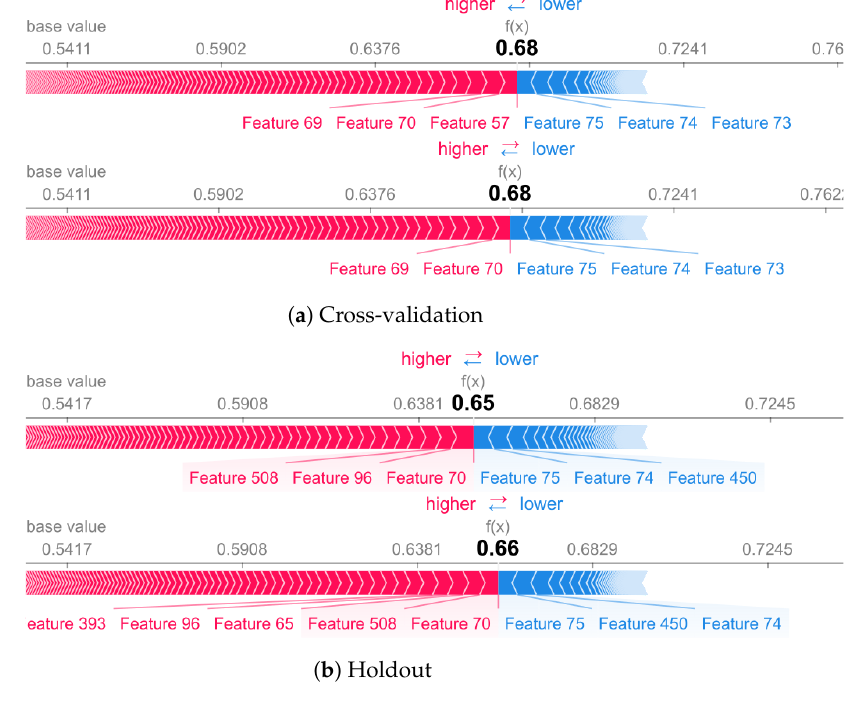
Figure 9. Walk activity for cross-validation ( a ) and holdout ( b ) validation methodology.